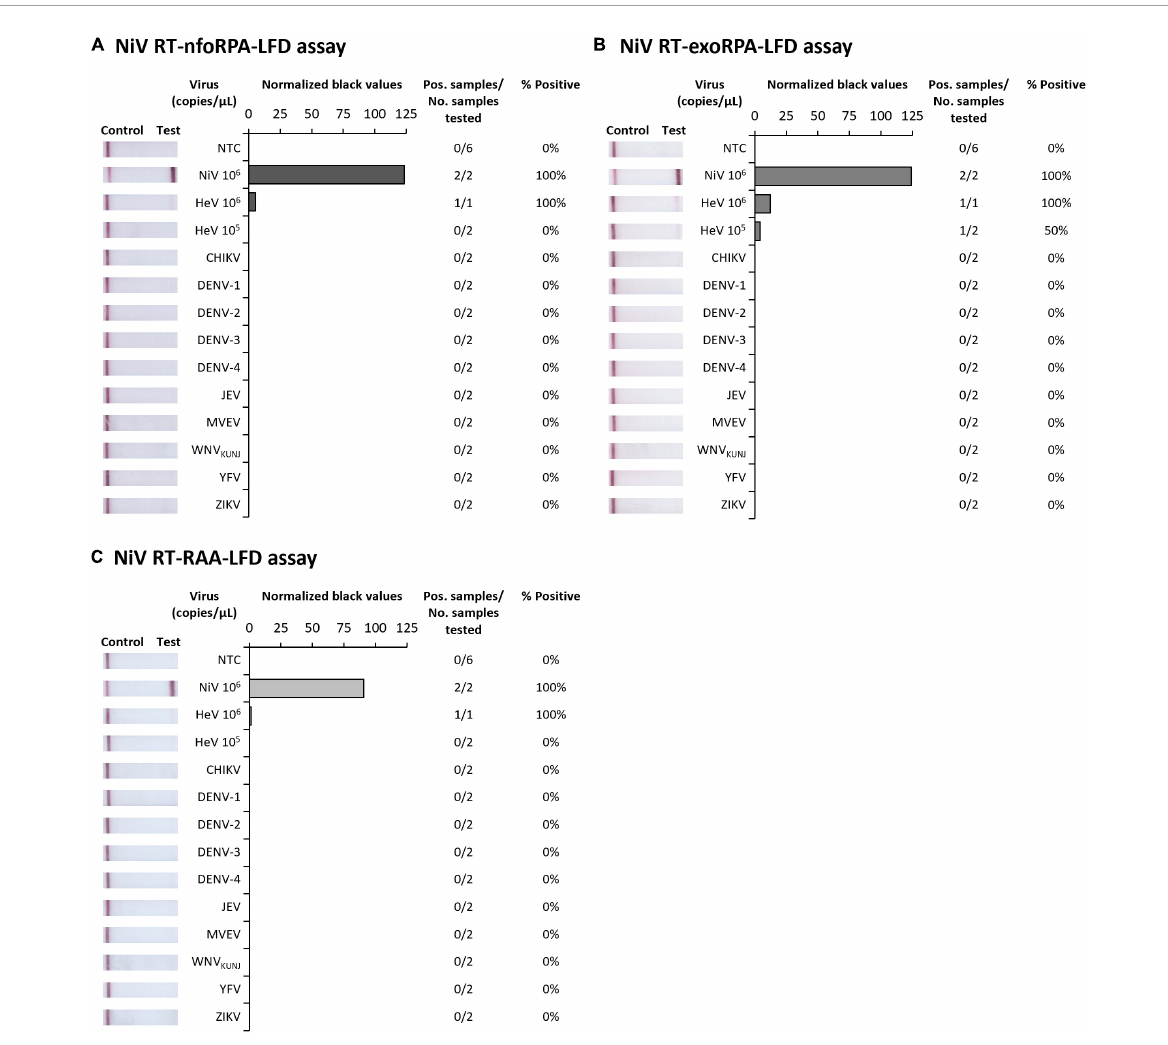
FIGURE2 Analytical specificities of three Nipah virus recombinase-based isothermal amplification lateral flow detection tests. Specificity testing used synthetic RNA of NiV and Hendra virus (HeV), and viral RNA extracts from alphavirus Chikungunya virus (CHIKV), and flaviviruses DENV-1, DENV-2, DENV-3, DENV-4, JEV, MVEV, WNV KUNJ , YFV, and ZIKV for RT-nfoRPA-LFD (A) , RT-exoRPA-LFD (B) , and RT-RAA-LFD (C) . Images of lateral flow strips with two bands (control and test band) indicates the sample is positive for respective viral RNA extract, and single control band indicates a valid reaction with negative sample. Nuclease-free water was tested as the no template control (NTC; left). Normalized pixel density (normalized black values) from the test displayed (middle). Positive samples compared to number of samples tested using different viral RNA transcripts and extracts were used to calculate percentage of positive samples